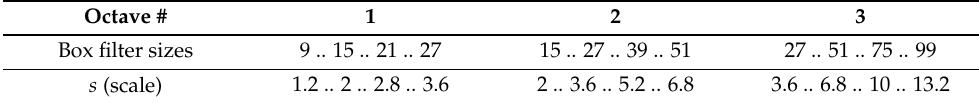
Table 2. Box filter sizes for the first three octaves. Octave # 1 2 3 Box filter